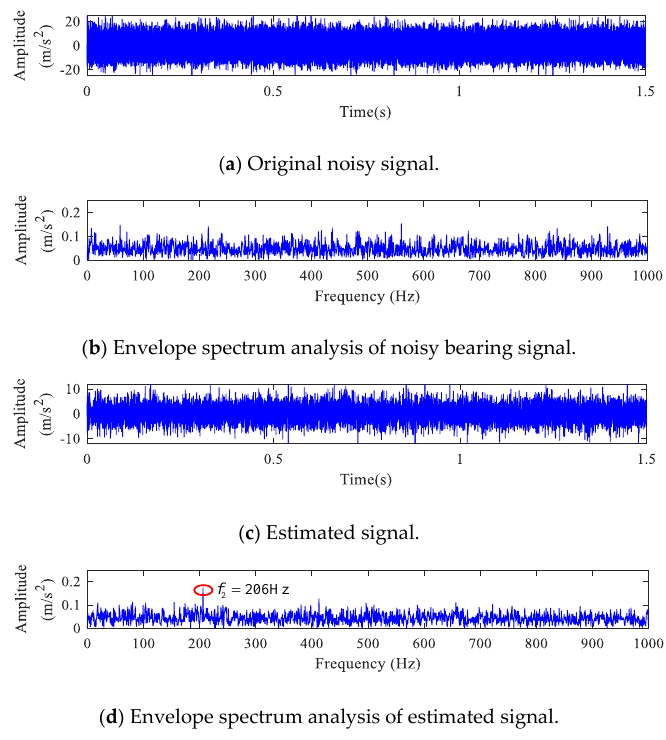
Figure 6. Results of experimental inner race fault signal.